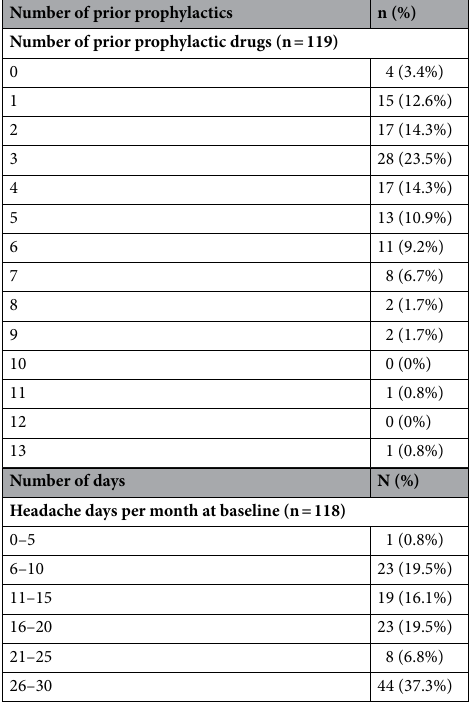
Table 1. Number of prior prophylactic treatments and headache days per month at